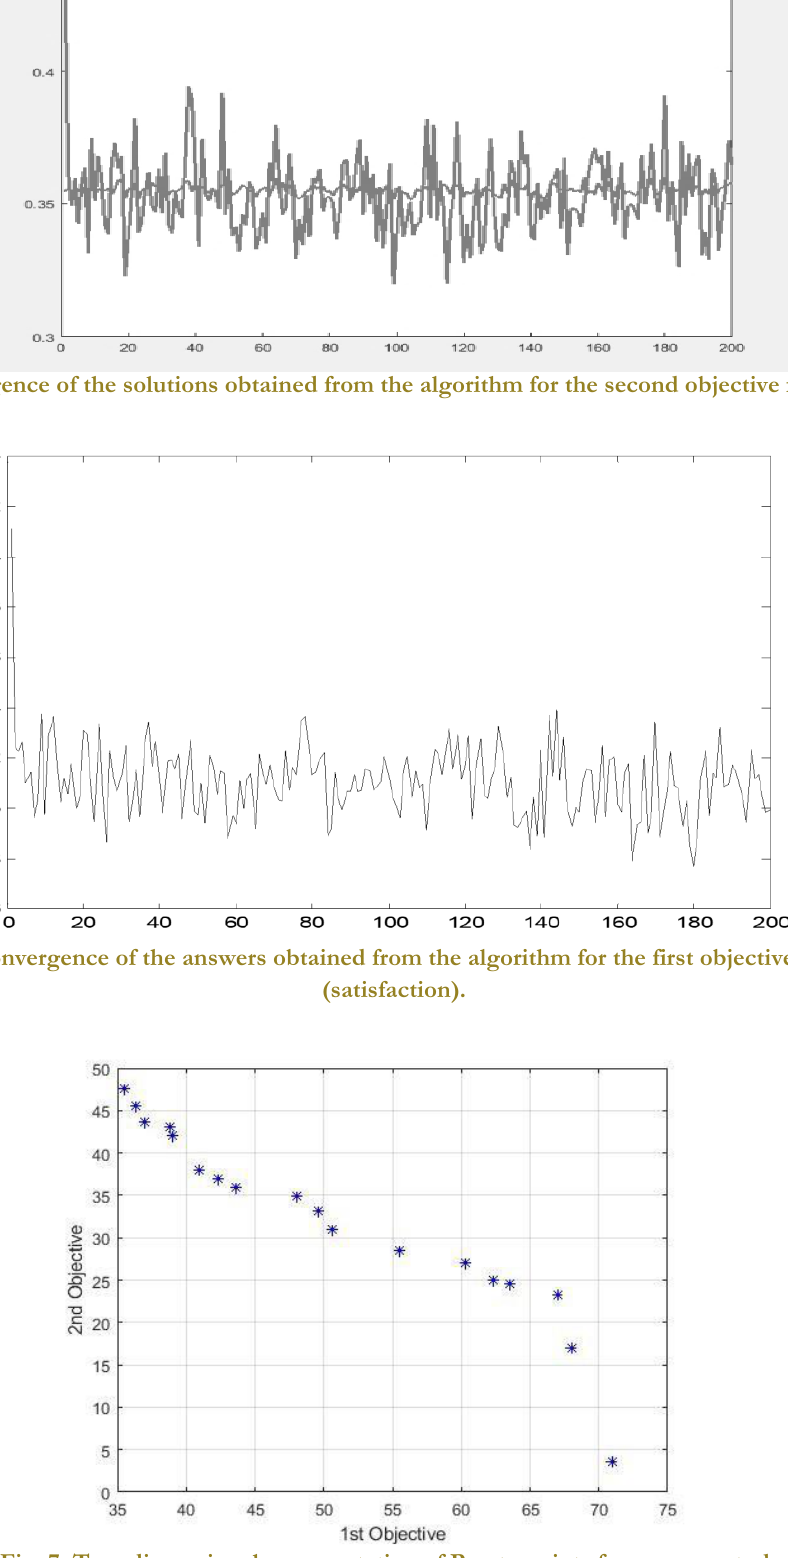
Fig. 7. Two-dimensional representation of Pareto points from a case